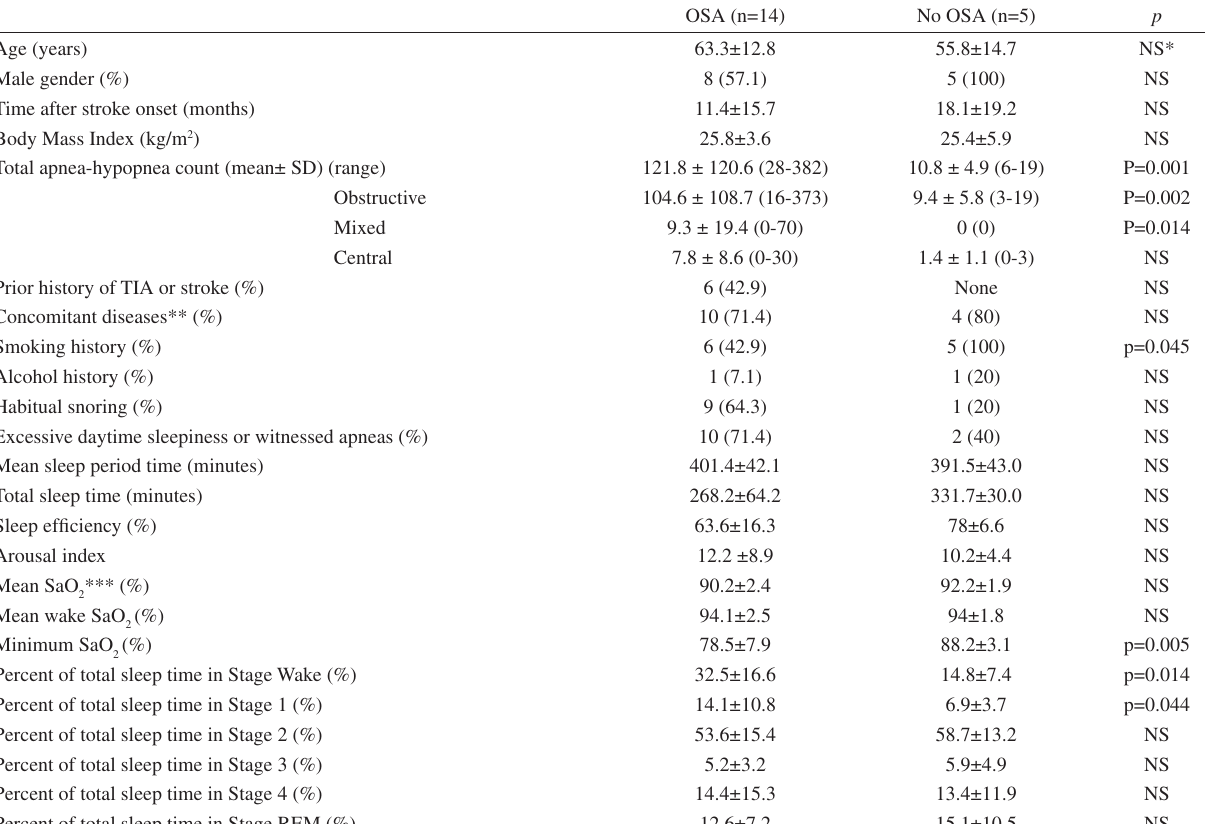
Table 1 - Characteristics and polysomnography data of stroke patients with and without obstructive sleep apnea